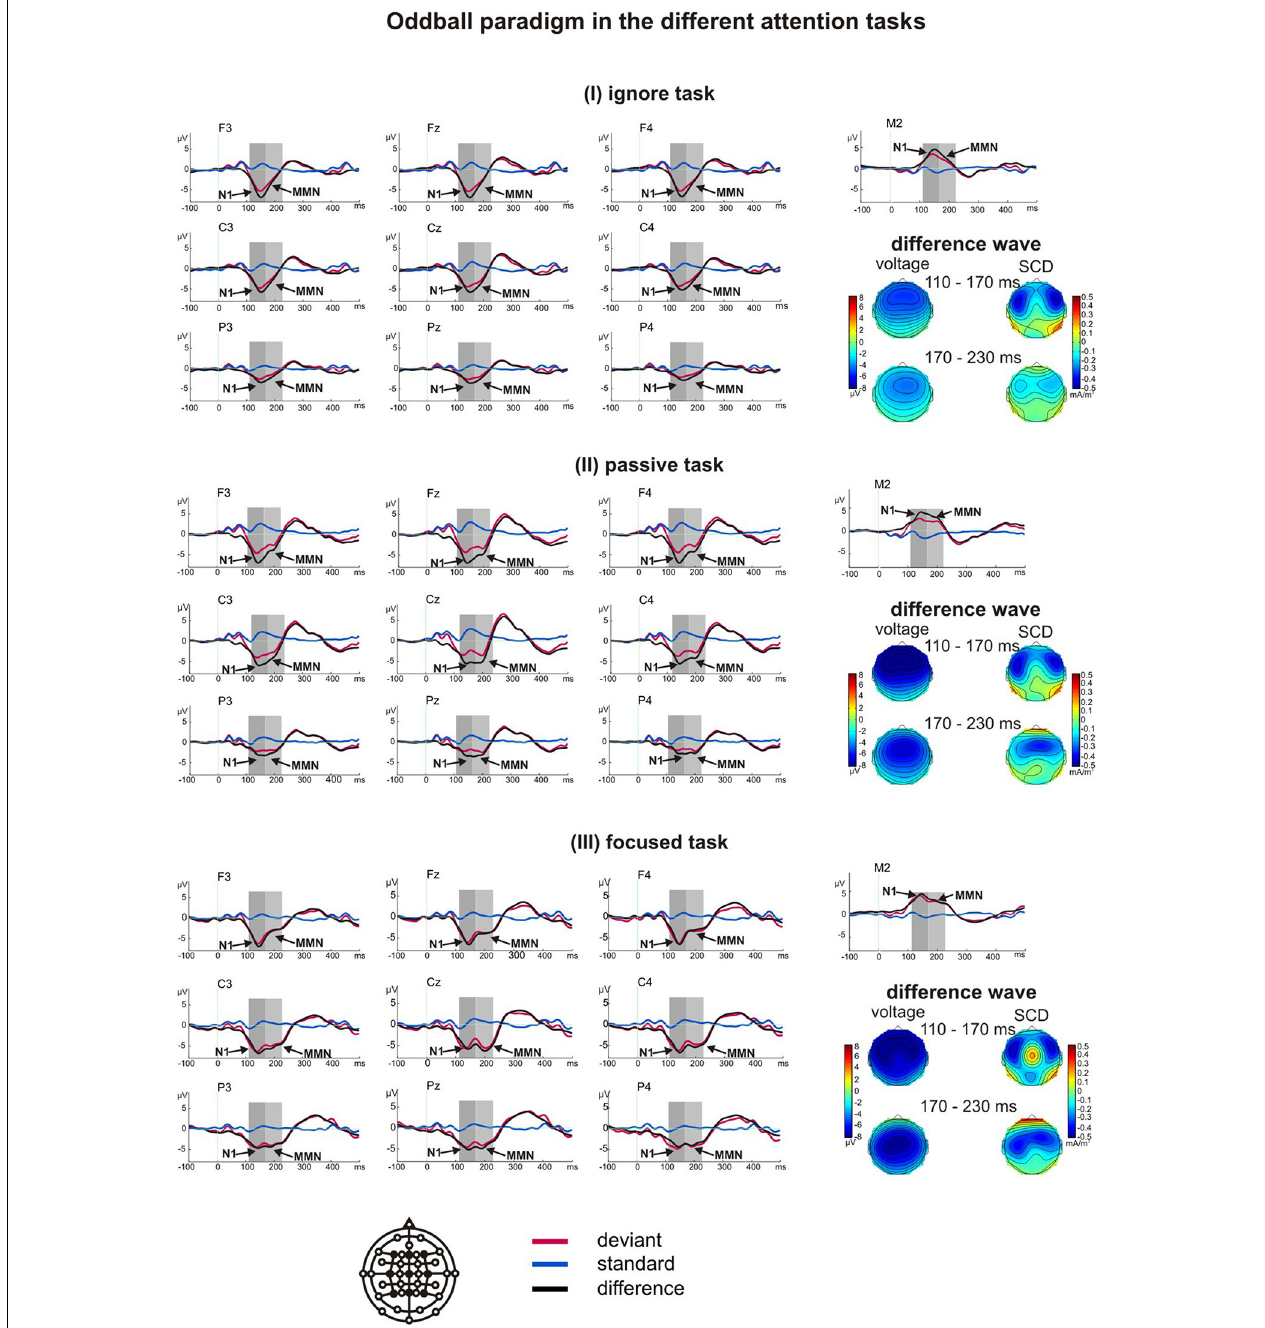
FIGURE 1 | Grand average ERPs of the oddball paradigm obtained in the ignoretask(I),passivetask(II)andfocusedtask(III). Thearrowsindicatethe critical significant components N1 and MMN and the gray boxes represent the